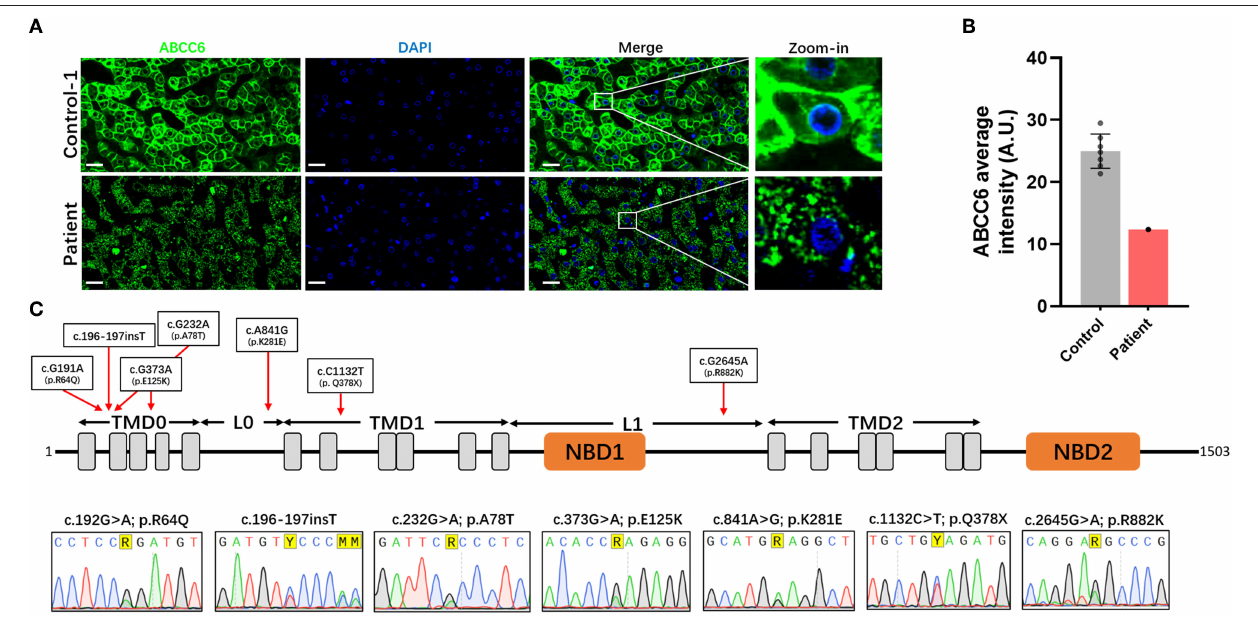
FIGURE 4 | Dysfunction of ABCC6 was observed in the hepatocytes of this patient. (A) The immunofluorescence of the liver in control-1 and patient. Green indicated ABCC6. Blue indicated cell nucleus. Scale bar = 20 µ m. (B) Average immunofluorescence intensity of hepatocellular ABCC6 in control group (A & ) and patient. (C) The domain structure of ABCC6 and positions of identified patient variants were indicated in the up pattern. The Sanger sequencing results were shown under the structure. TMD, transmembrane domain; L, linker region; NBD, nucleotide binding